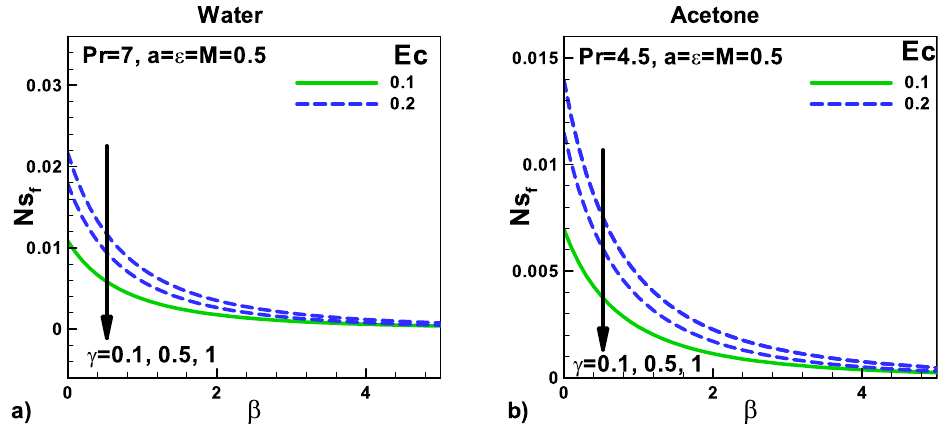
Figure 13. Variation of entropy generation rate due to friction with velocity and thermal slip parameters for ( a ) water ( b ) Acetone.